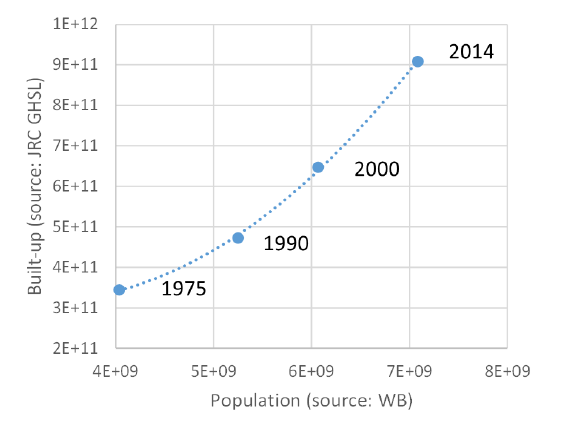
Figure 5: Global population and built-up areas evolution in the last 40 years. The fine-scale built-up areas are estimated by the JRC GHSL using Landsat input